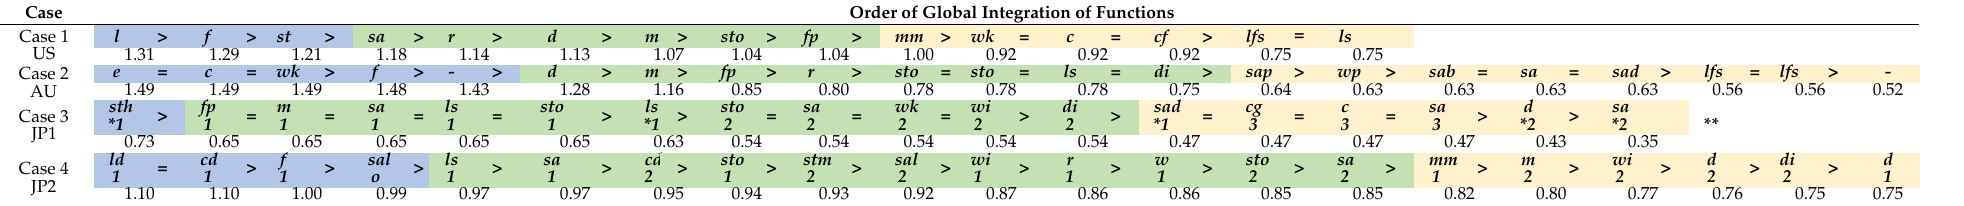
Table 2. Order of global integration of functions from axial line analysis.